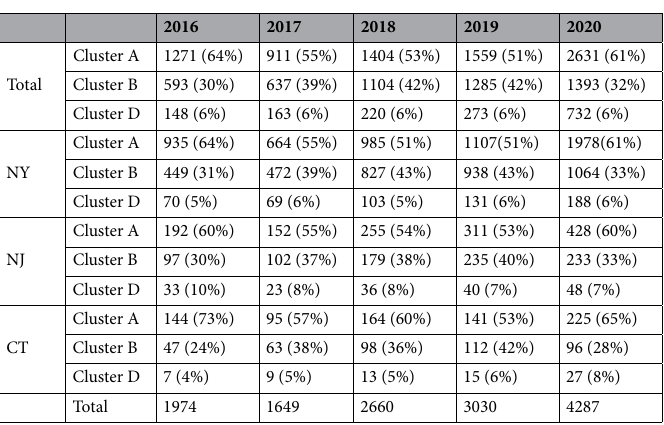
Table 3. The number of tweets from 2016 to 2020 by state and